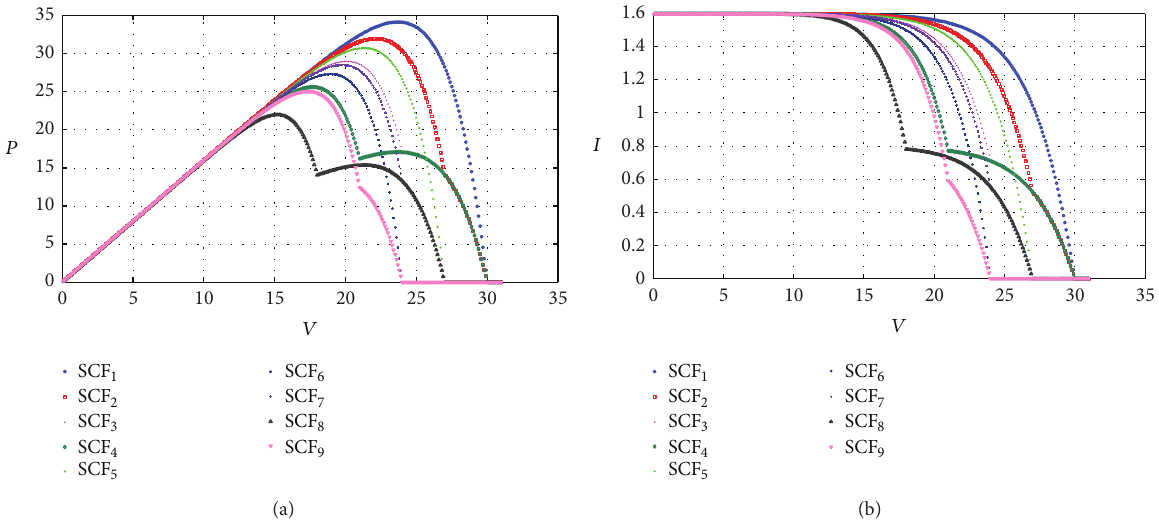
Figure 6: (a) V-P characteristic curves of nine faults. (b) V-I characteristic curves of nine faults.